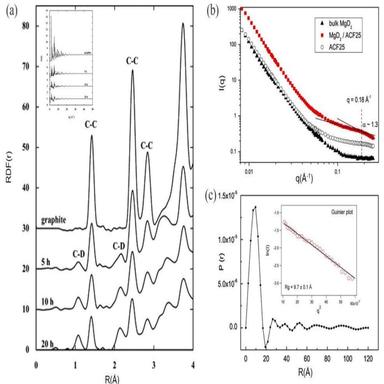
(a) Radial distribution functions, RDF(r), derived from Fourier transformation of S(Q) for (Mg/G)BN milled with C6D6 different time. Inset: structure factors, S(Q), obtained by neutron diffraction; (b) The SANS measurements at room temperature performed on bulk MgD2, (ACF25), and MgD2/ACF25; (c) Volume distribution of sizes obtained via indirect Fourier transform of the difference between ACF25 and MgD2/ACF25. The upper size limit was 12 nm for the transform. Inset: Guinier plot in the high-